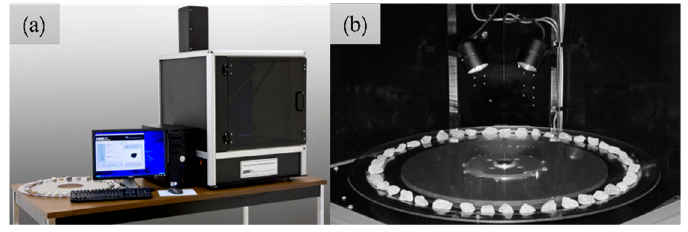
Figure 4. Aggregate image measurement system ( a ) and aggregates being tested ( b ).